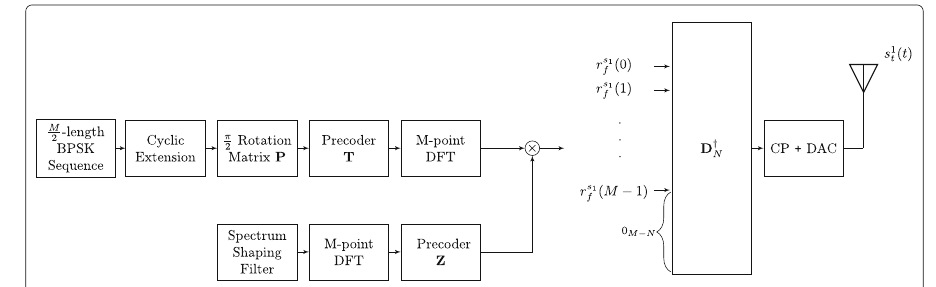
Fig. 8 Transmitter architecture for port 1 DMRS waveform generation using method 1